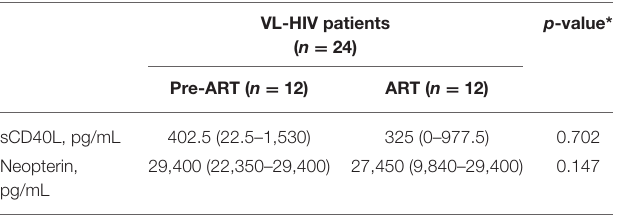
TABLE 2 | Median and interquartile ranges for sCD40L and neopterin levels with regard to ART status in active VL-HIV patients.